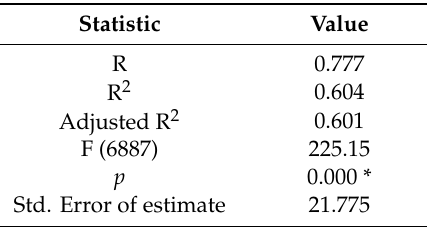
Table 12. Statistic of multiple